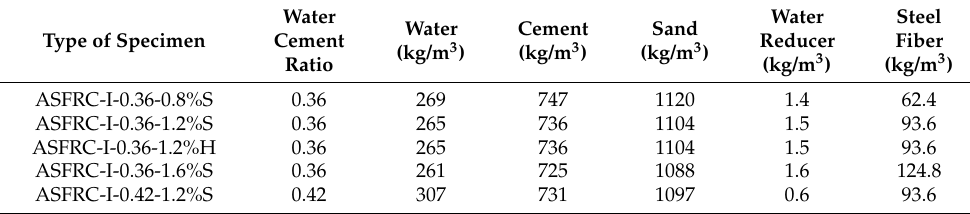
Table 1. Mix proportion of steel-fiber-reinforced cementitious composites.